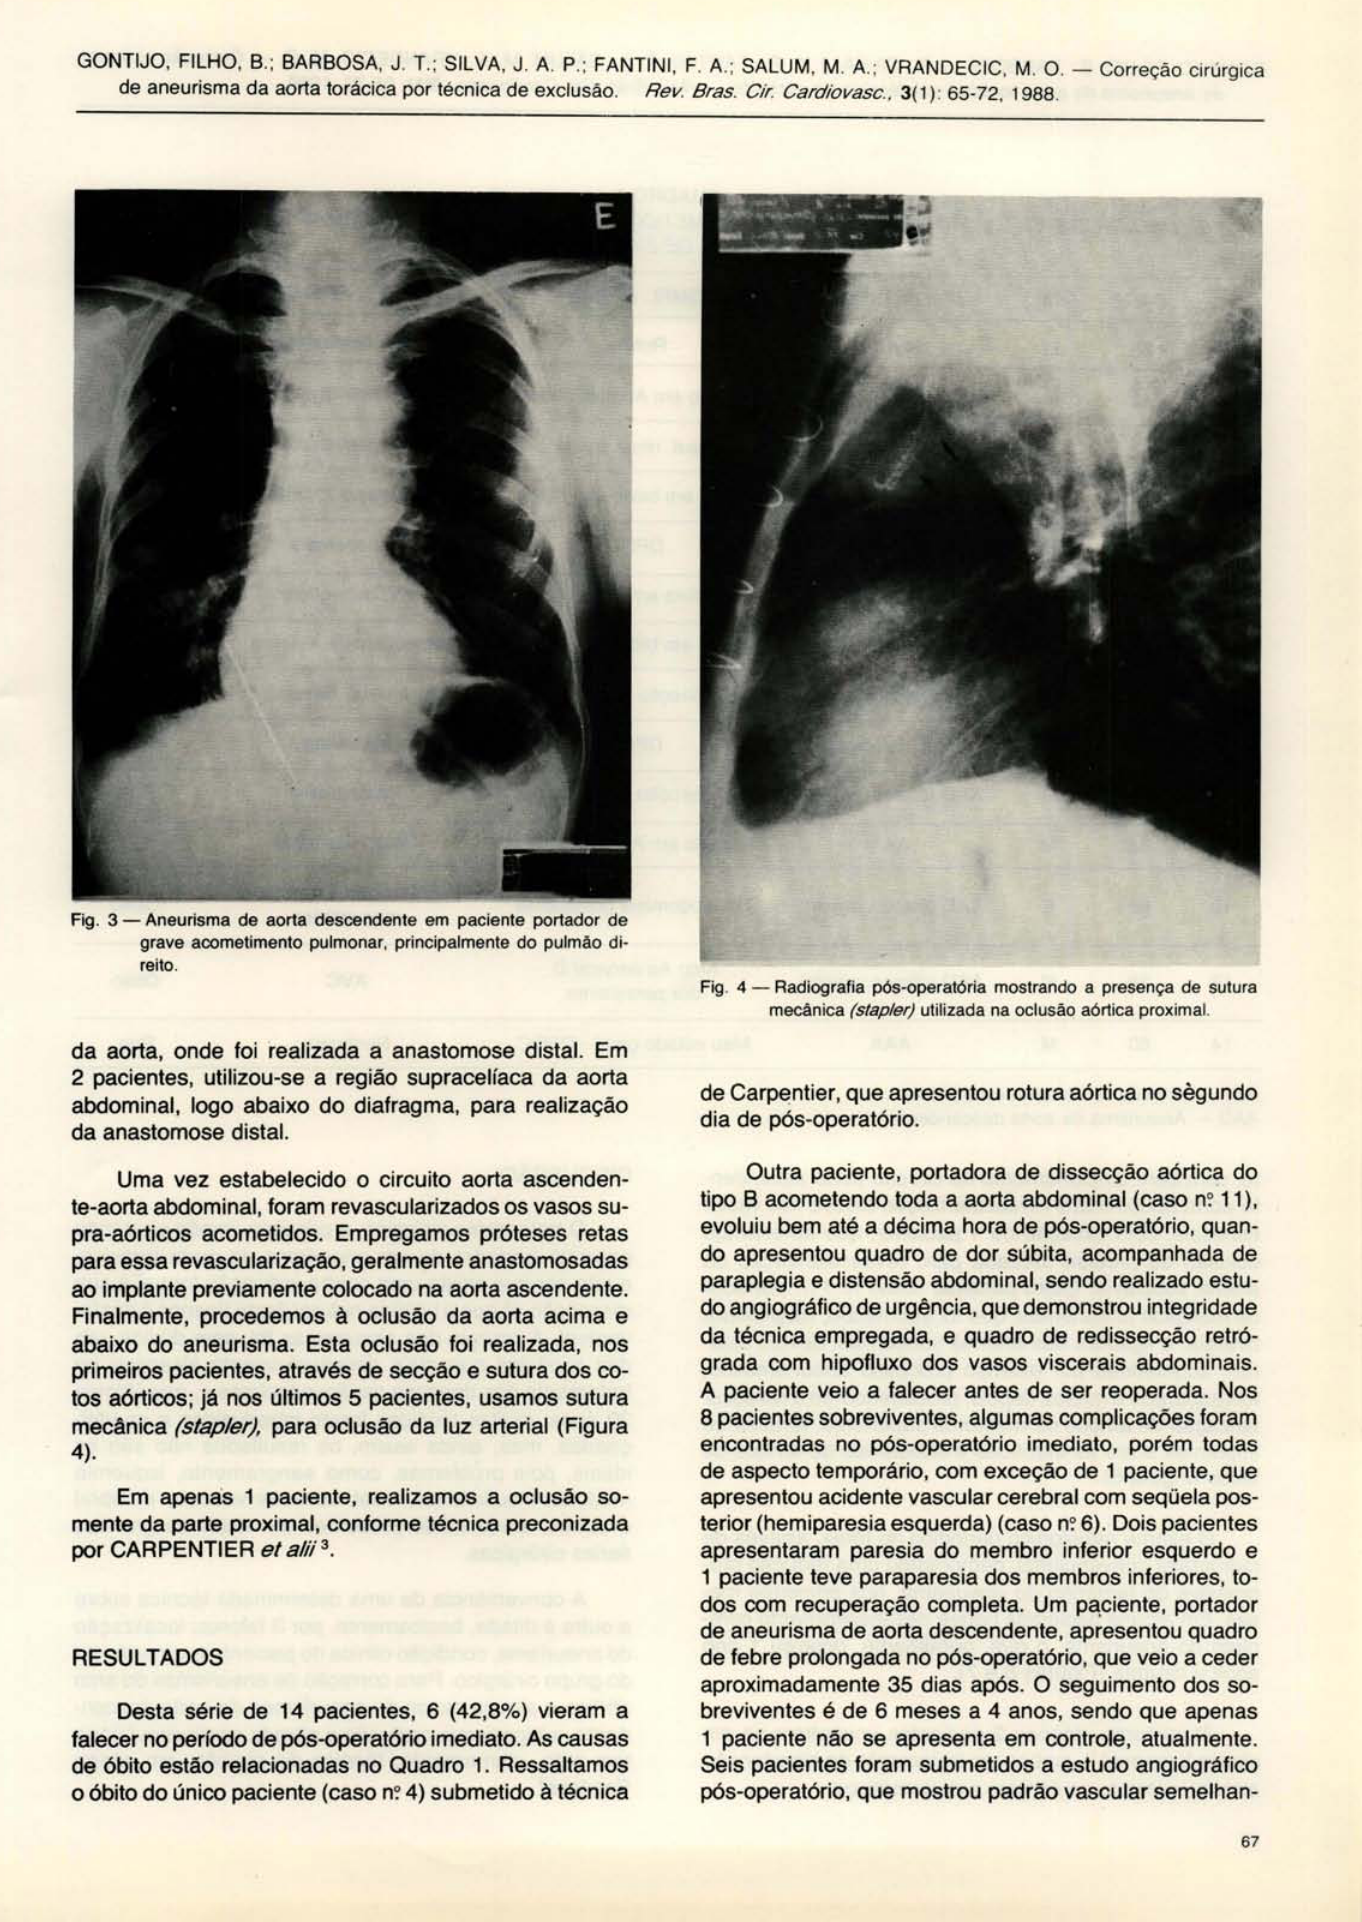
Fig. 4 - Radiografia pós-operatória mostrando a presença de sutura mecãnica (stap/er) utilizada na oclusão aórtica